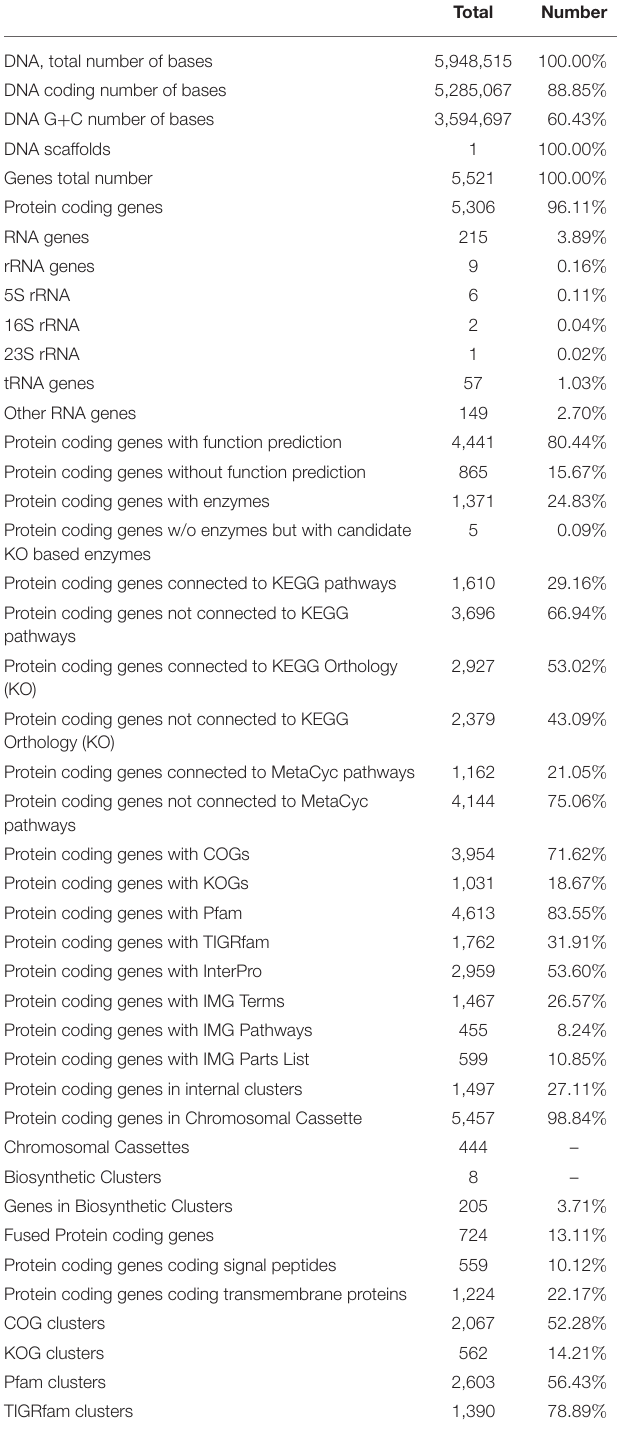
TABLE 2 | Genome properties and features of S211